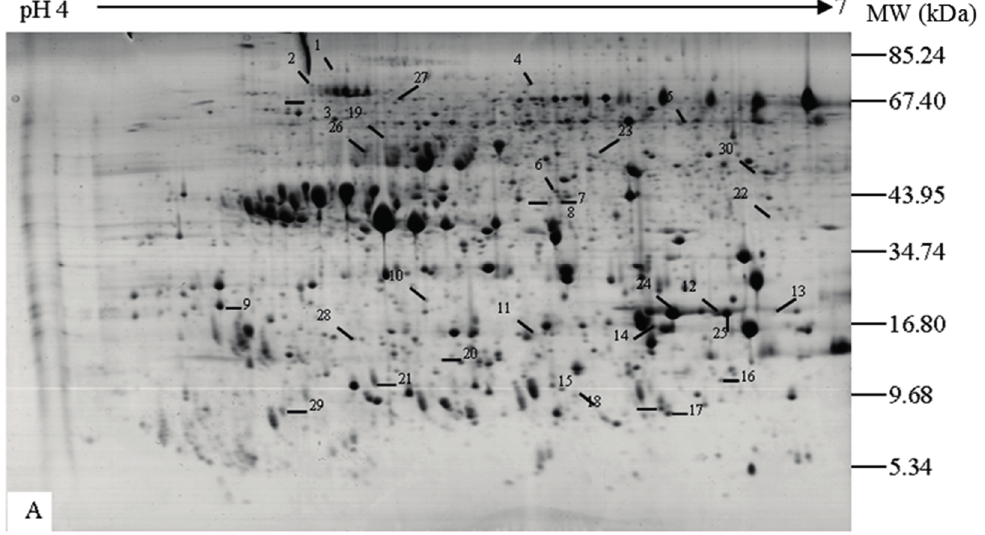
Figure 1. Explants derived from Fraxinus mandshurica immature zygotic embryo cotyledons with different characteristics after 40 days of culture. ( A ) non-browned explants without somatic embryos (NBNSE); ( B ) browned explants with somatic embryos (BSE) (somatic embryos were removed when sampling); and ( C ) browned explants without somatic embryos